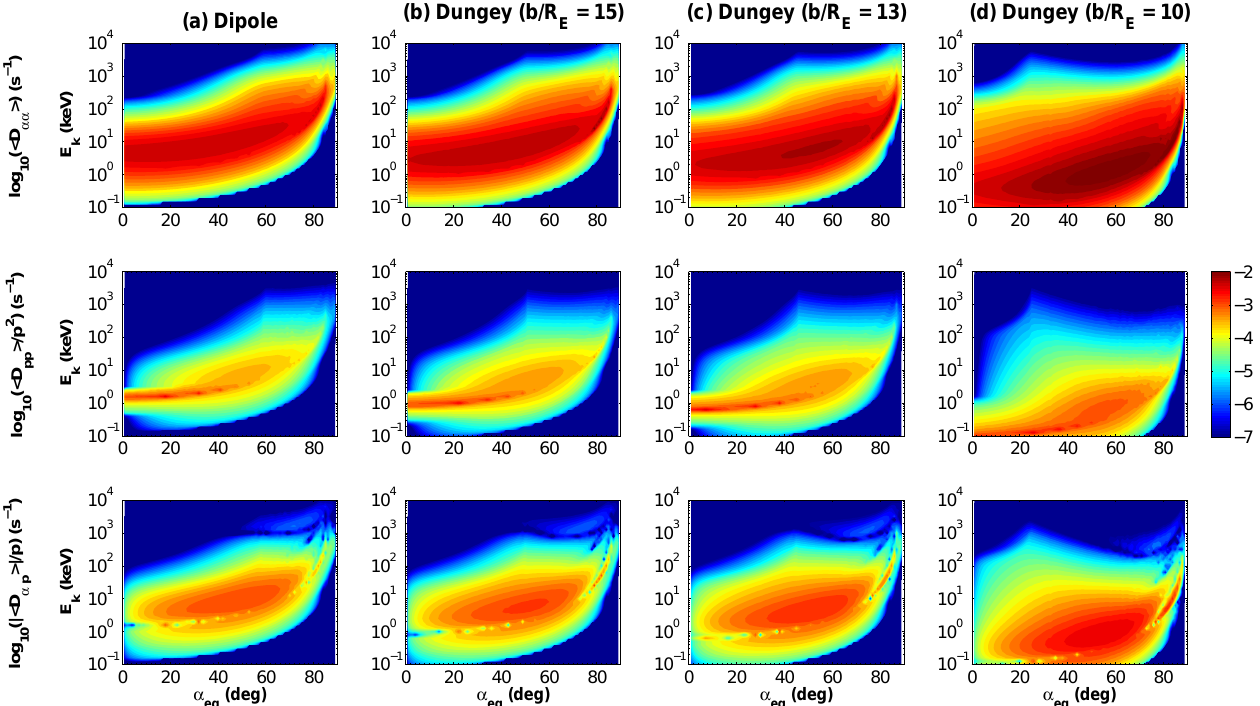
Fig. 6. Same as Fig. 4, expect for r 0 = 9 R E with b / R E = ∞ (dipole), 15, 13 and 10.